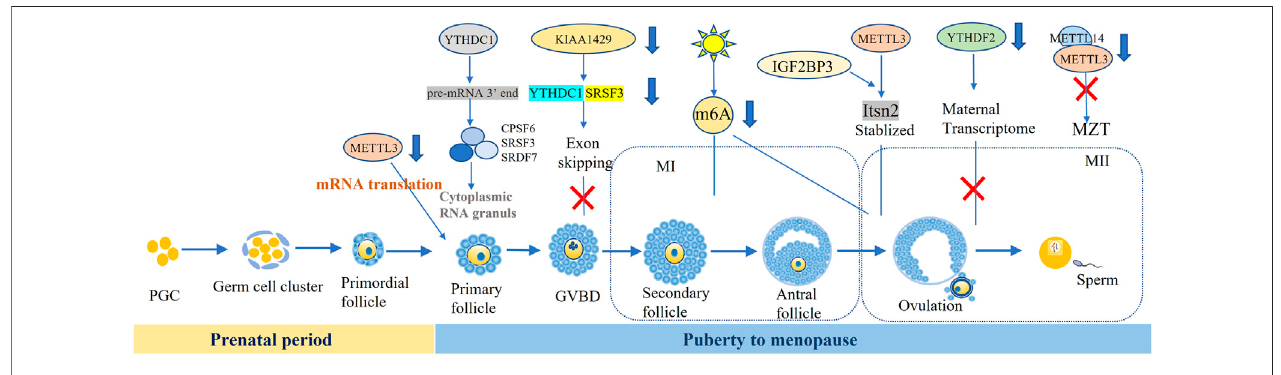
FIGURE 1 | m 6 A and regulators participate in the oocyte development and